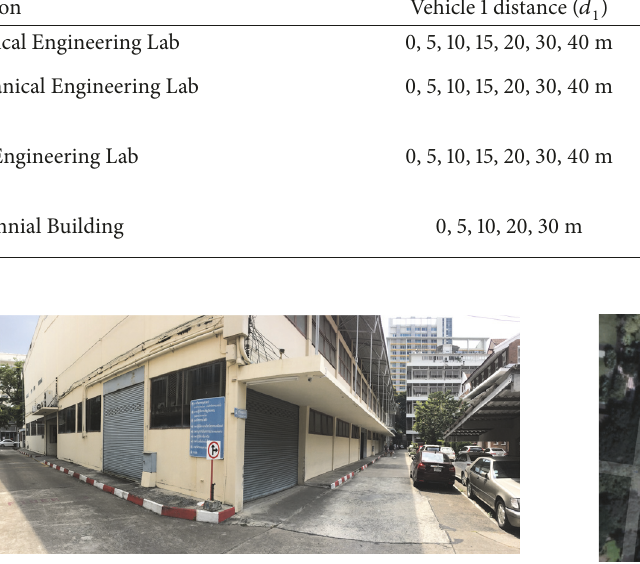
results of the fourth blind corner (Centennial Building).